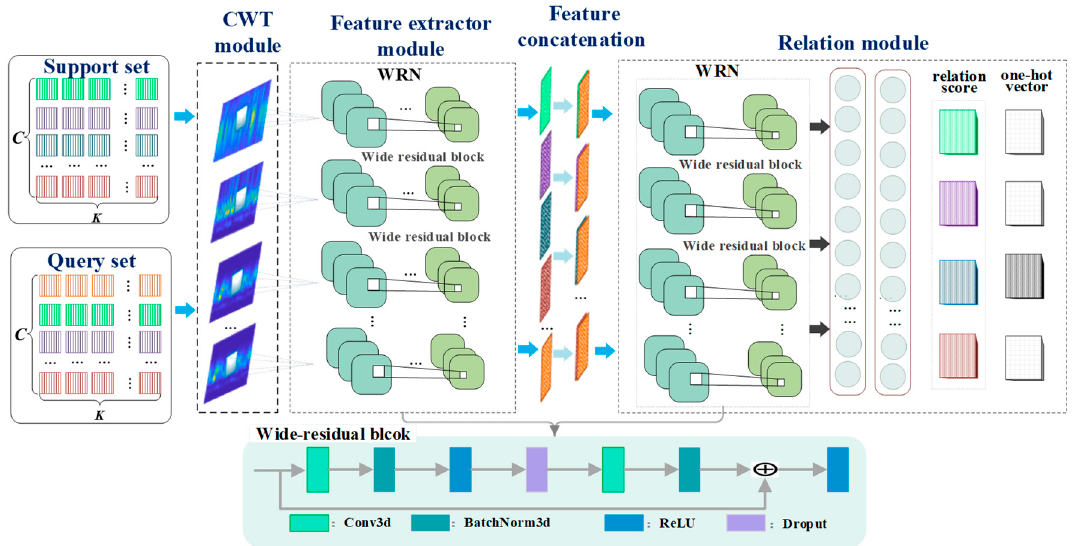
Figure 1. Structure illustration of the proposed TRPGN model.